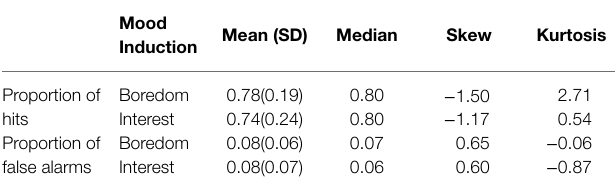
TABLE 2 | Proportions of hits and false alarms as a function of mood induction